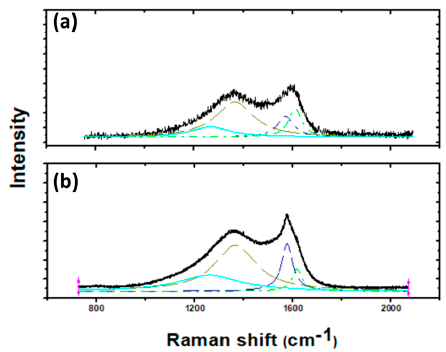
Figure 2. Comparison of peak intensities and peak width of Raman spectroscopy of ( a ) CNF and ( b